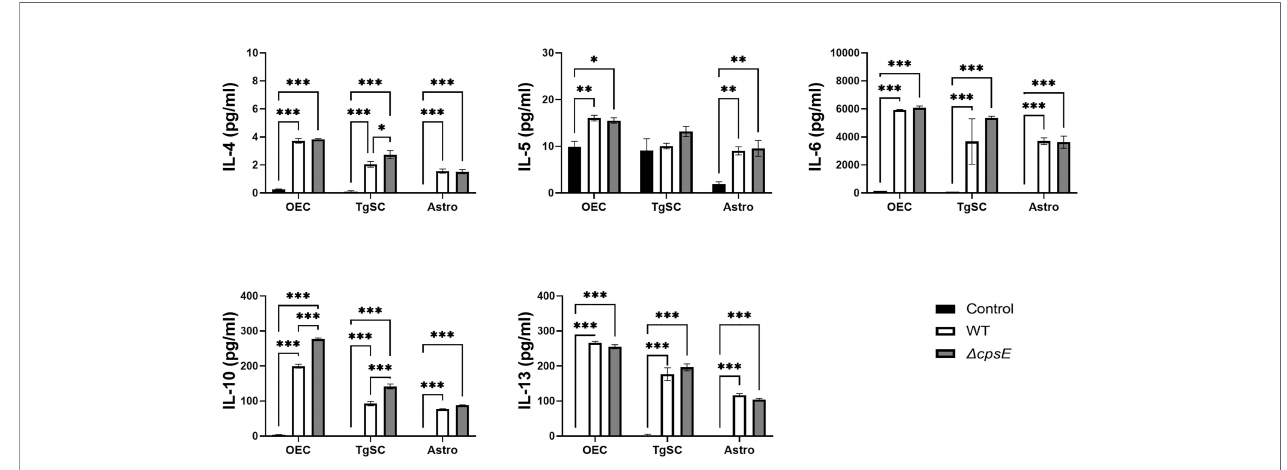
FIGURE 9 | Anti-in fl ammatory cytokine responses in glia after inoculation with wild-type and capsule-de fi cient S. agalactiae . OECs, TgSCs and astrocytes were inoculated with either WT or D cpsE (MOI 100:1) after which the cytokine levels in the medium were analysed at 24 h post inoculation. Data show mean ± SEM, *p ≤